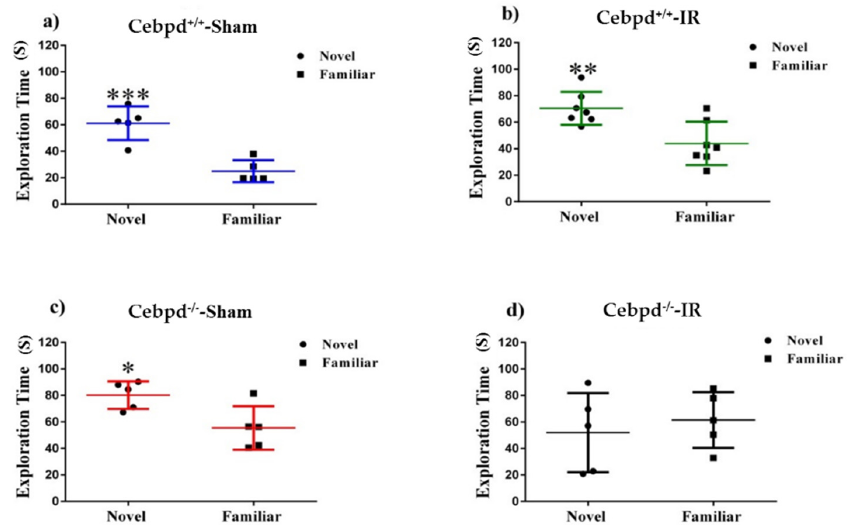
Figure 2. NOR of sham-irradiated and irradiated aged Cebpd +/+ and Cebpd − / − mice. ( A ) Cebpd +/+ -sham, ( B ) Cebpd +/+ -IR, and ( C ) Cebpd − / − -sham irradiated mice showed novel object recognition and spent more time exploring the novel than the familiar object. However, Cebpd − / − -IR ( D ) mice did not show any preference for the novel object. N = 5/7 mice/treatment. Average ± SEM; * p < 0.05, ** p < 0.01, *** p < 0.001. 2.2.1. Dendritic Morphology of Dentate Gyrus Granule Neurons is Significantly Altered in Irradiated Cebpd − / − Mice